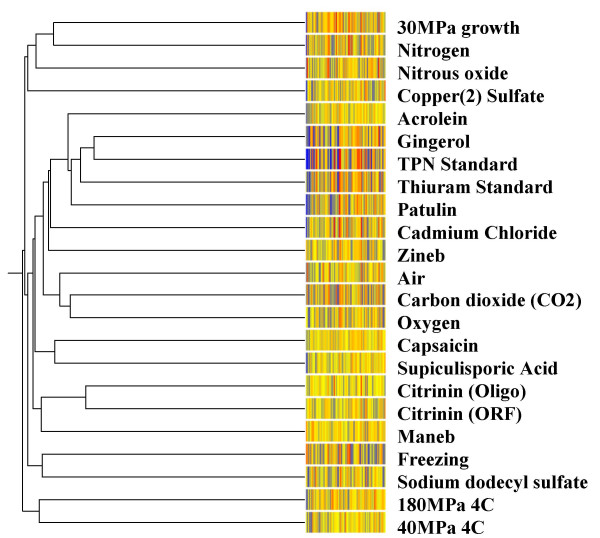
Cluster analysis of the mRNA expression profiles after the citrinin treatment. Hierarchical cluster analysis was performed using GeneSpring as described in the text.